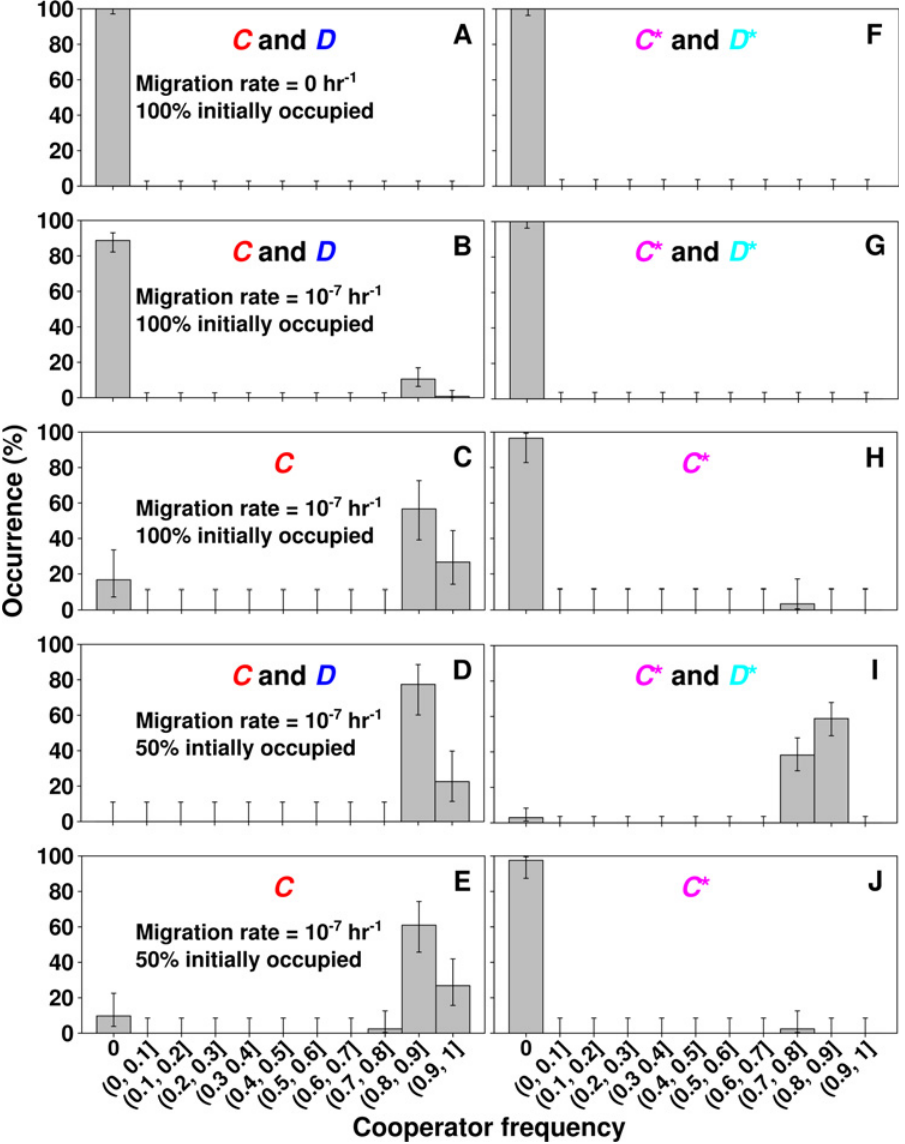
Fig 3. Migration, empty locations, and sometimes even the initial presence of defectors can increase the survival of cooperators. Each metapopulation was binned according to the frequency of cooperators averaged over the last 5 data points (800 hrs) of the entire simulation. A-E ) Metapopulations with C and D only. F-J ) Metapopulations with C * and D * only. Since the fitness of C * and D * differed from that of C and D , levels of cooperator survival differed in the two cases. A , F ) In initially fully-occupied metapopulations without migration, cooperators went extinct in all metapopulations. B ) Intermediate (10 − 7 hr -1 ) migration could promote cooperator survival frequency (15/133 in B compared to 0/131 in A ; p < 10 − 4 , Fisher's Exact Test), demonstrating that empty space arising from defector-induced extinction can sometimes rescue cooperators. C , H ) Increasing the initial cooperator frequency to 100% improved cooperator survival in an initially fully- occupied metapopulation (compare to B , G ). D , I ) The initial presence of empty locations improved the survival of cooperation (compare to B , G ). E, J ) With initially empty locations, the initial presence of defectors can promote cooperator survival (compare D with E ; I with J ). Error bars indicate an estimate of the 95% confidence interval (CI) based on the Wilson method